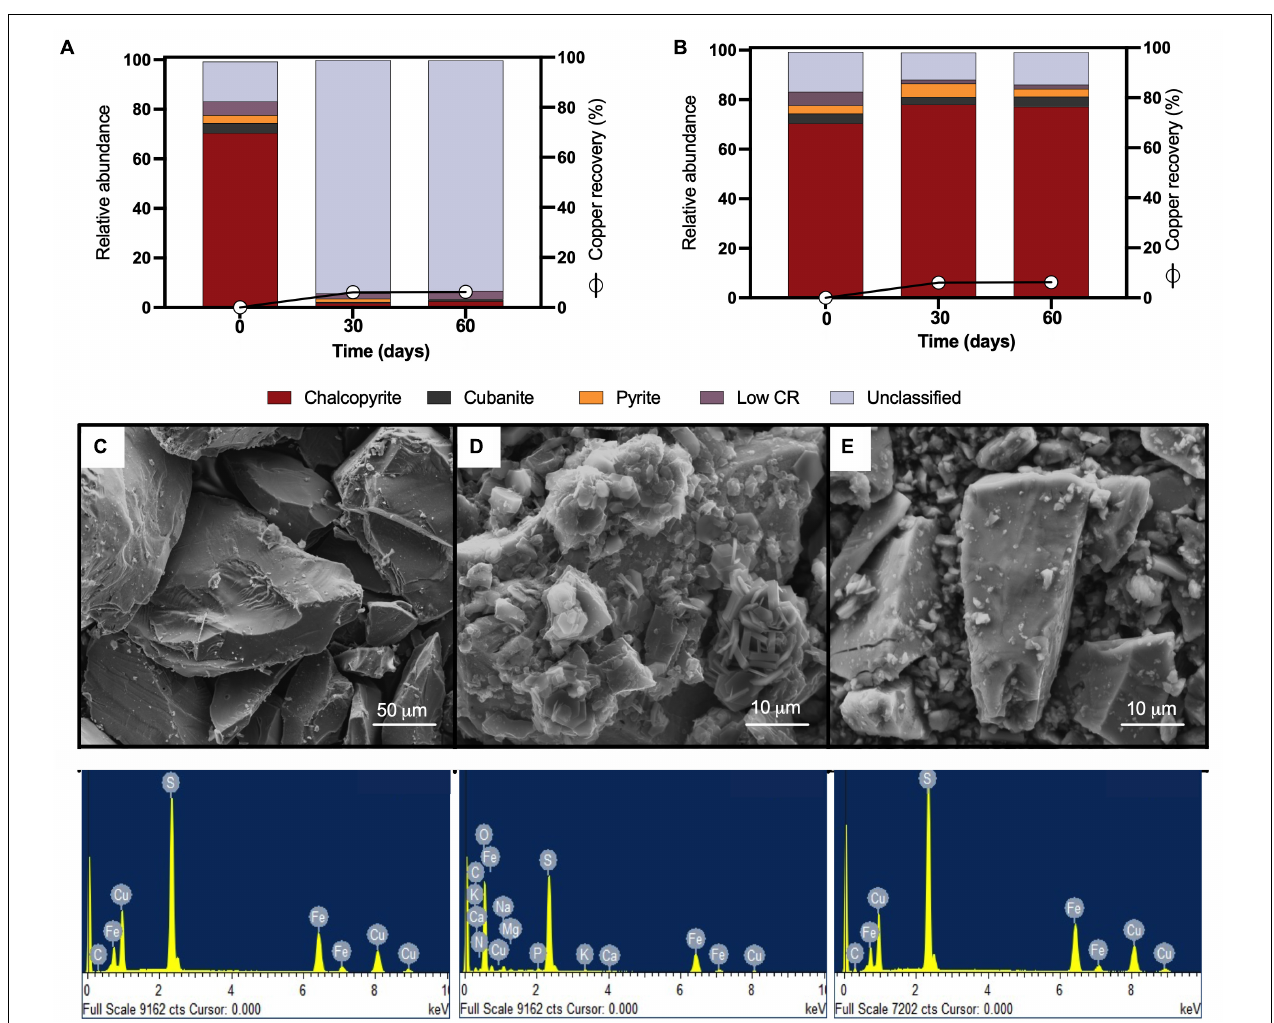
FIGURE 2 | QEMSCAN-BMA analysis of high-purity natural chalcopyrite before bioleaching (t0) and after flow cell bioleaching assay (30 days) for (A) turbulent and (B) laminar conditions. (C) SEM image and EDS spectrum of high purity chalcopyrite before bioleaching. SEM images and EDS spectra of high-purity chalcopyrite after 30 days of (D) turbulent (screening method) and (E) laminar flow mesophilic bioleaching (flow cell method). Low CR: no mineral